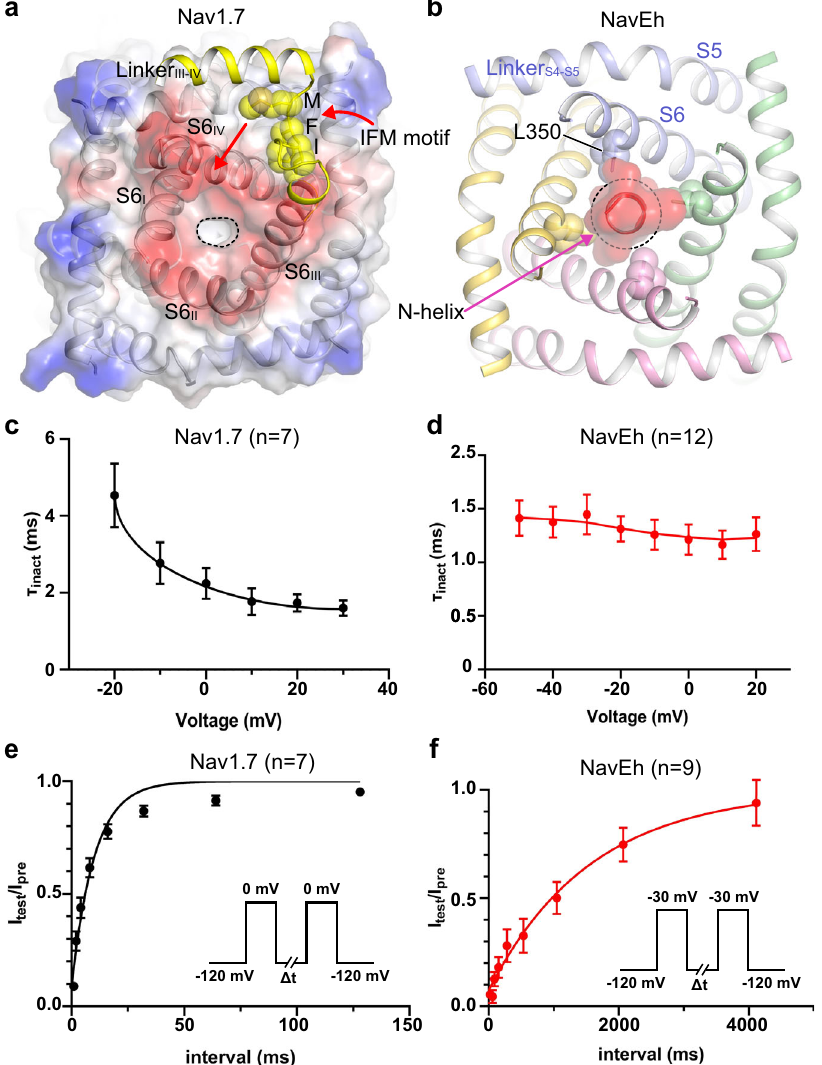
Fig. 5 Comparison of N-helix and IFM-motif mediated inactivation. a , b Cartoon representation of the IFM-motif mediated allosteric inactivation of human Na V 1.7 (PDB: 6j8j) and the N-helix mediated inactivation of Na V Eh. IFM-motif shown in spheres and colored in yellow. Dashed black circle indicates the gate size. c , d Fast inactivation time course of Na V 1.7 ( n = 7) and Na V Eh ( n = 12). The time constant was plotted to the test voltages. e , f The time course for recovery from fast inactivation of Na V 1.7 ( n = 7) and Na V Eh ( n = 9). For each point, data are means + / − SEM. Source data are